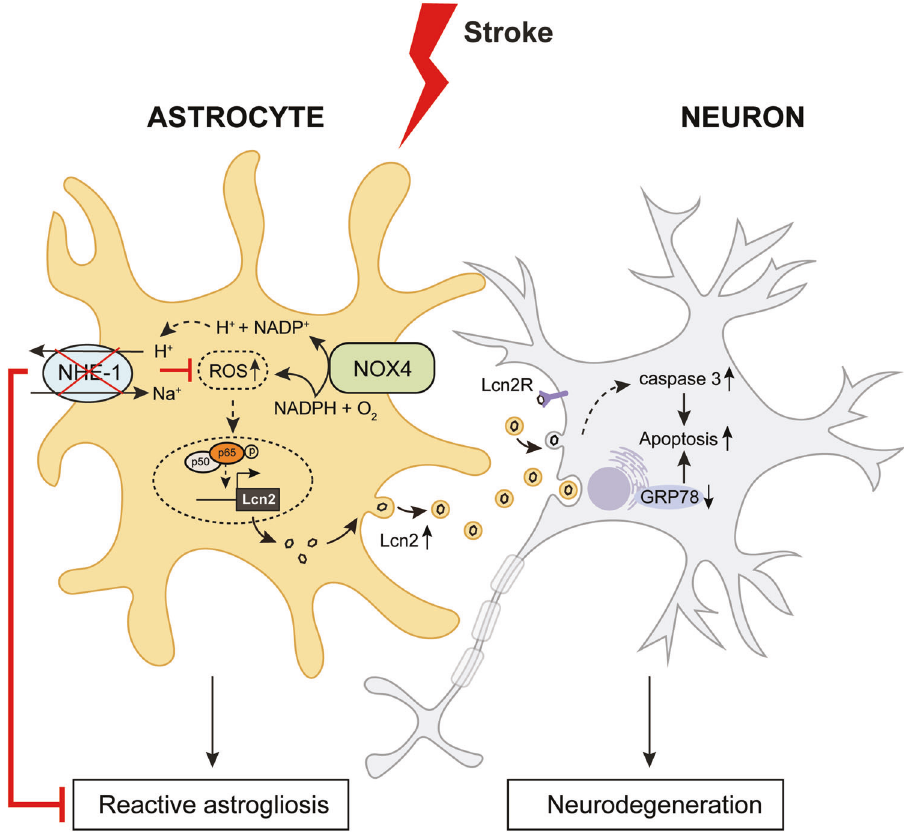
Fig. 8 Schematic diagram illustrating NHE1 mediated mechanisms in regulation of LCN2 expression and release from stroke-induced RA. Ischemia stimulates NHE1 expression and activation in RA. Overstimulation of NHE1 activity leads to increased NOX mediated ROS production and NF- κ B activation which induces LCN2 gene expression. Increased release of LCN2 + exosomes from RA induces neurodegeneration and neuronal apoptosis. Astrocyte speci fi c deletion of Nhe1 reduced LCN2 induced neuronal loss and neurodegeneration by inhibiting LCN2 + exosome release from